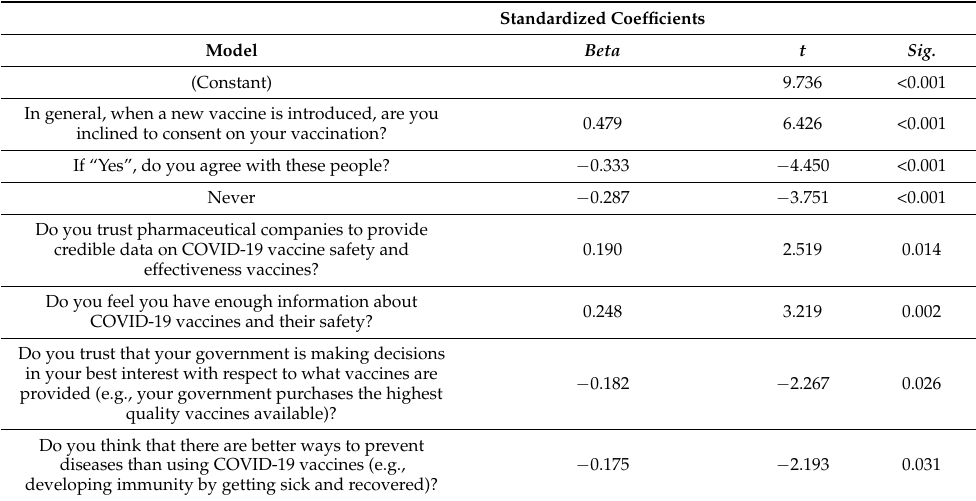
Table 8. Model of Palestinian dental students’ attitudes towards COVID-19 vaccine, February— March 2021 ( n =